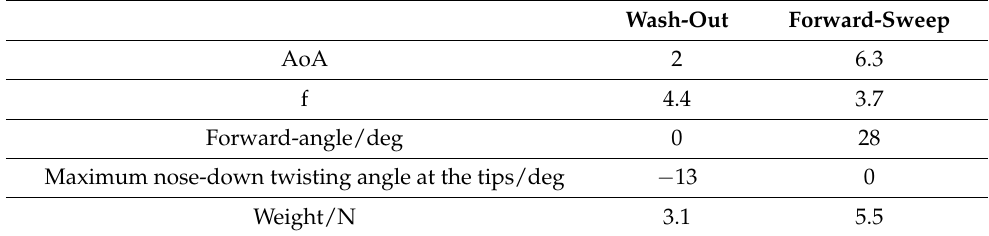
Table 4. The trimmed results by two methods independently.